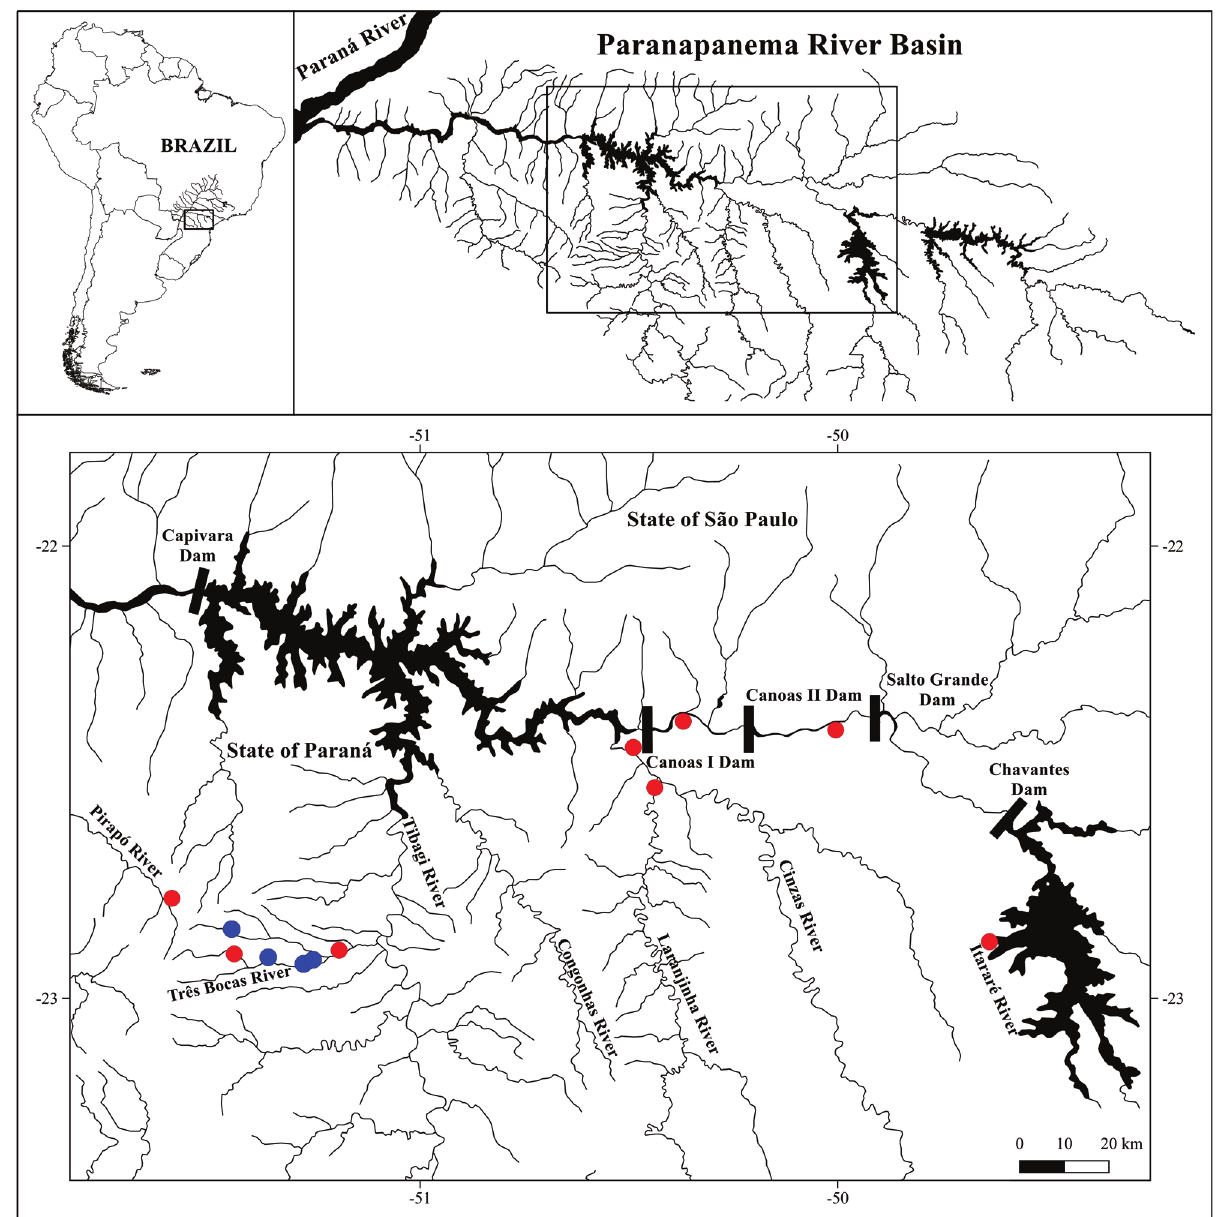
Figure 1. Map of the Paranapanema River basin with the location of the evaluated areas (red dots: fish production, blue dots: ‘fish and pay’). brood stock (Kostow 2009, Almeida et al. 2013). The introduction The decreased controls of the production of non-native risk is compounded by a range of additional consequences that fish species in Paranapanema River basin over the last twenty non-native fishes can have in the wild, including altered habitat years have also been concomitant with an increase in the num- structure, hybridization, disease transmission, and increased ber of ‘fish and pay’ sites. These are fisheries used for angling trophic interactions (e.g. predation and competition) that can that are mainly stocked with large-bodied fishes to maximise lead all negatively impact native fauna (Agostinho et al. 2007, angler attraction and satisfaction, with species used Vitule et al. 2009, Ashikaga et al. 2010, Alves et al. 2014).